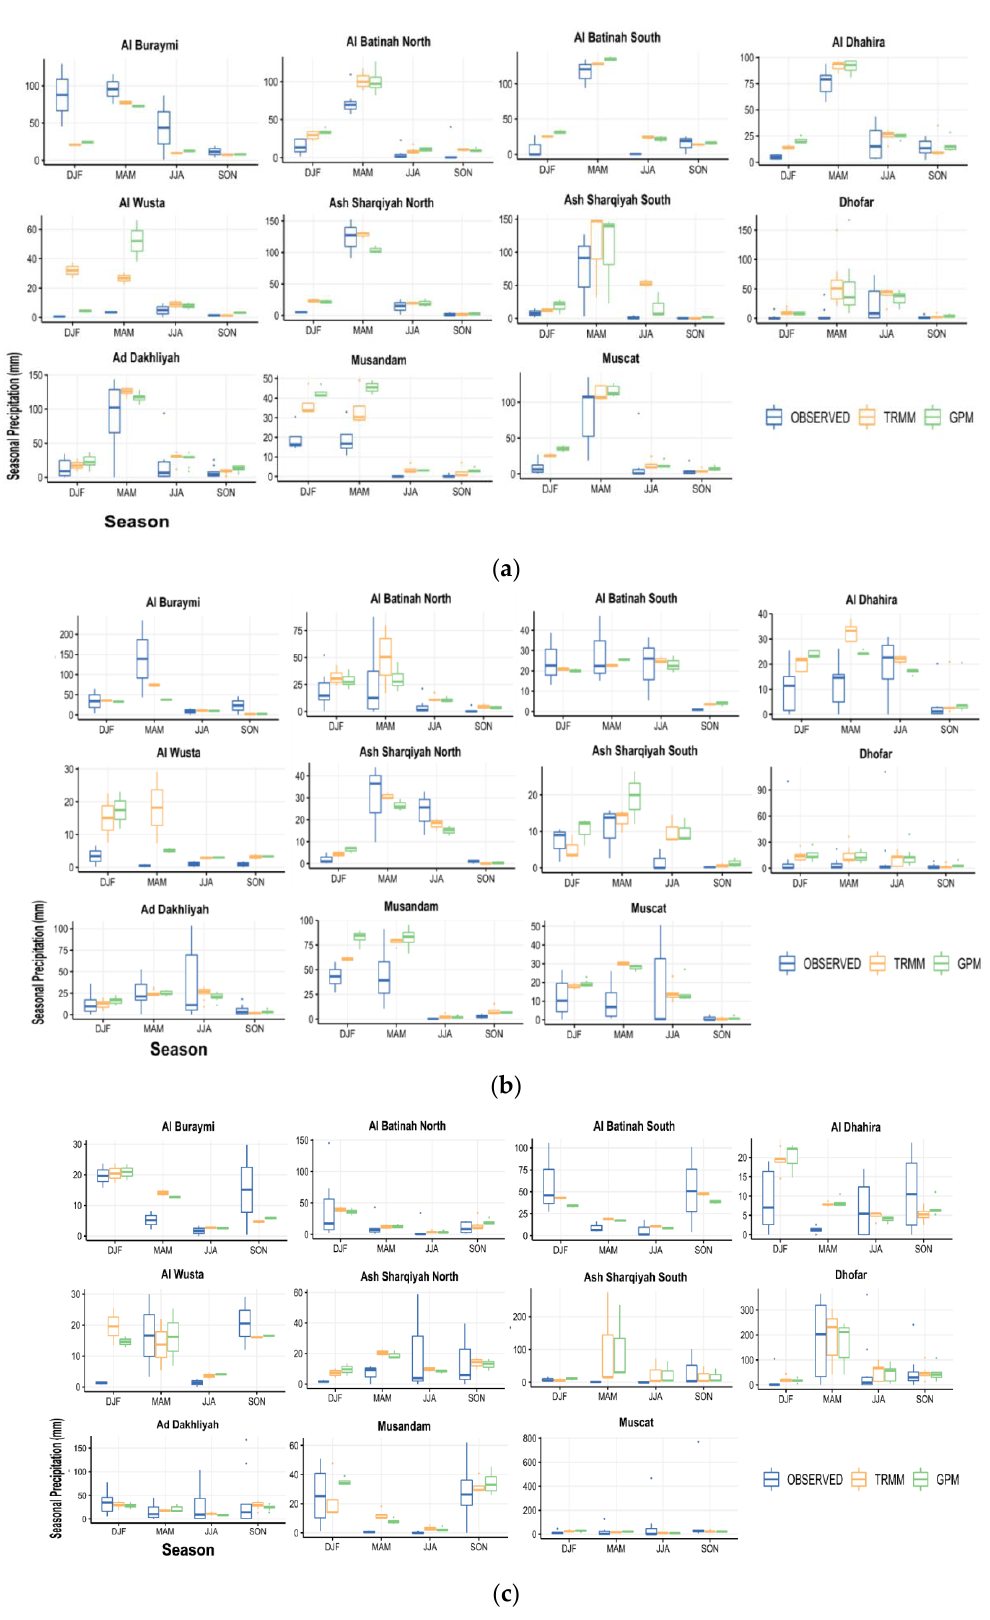
Figure 7. Seasonal averages of precipitation estimates from NCSI (OBSERVED, (blue)), GPM (green), and TRMM (orange)) across the 11 governorates of Oman for ( a ) 2016, ( b ) 2017, and ( c ) 2018.